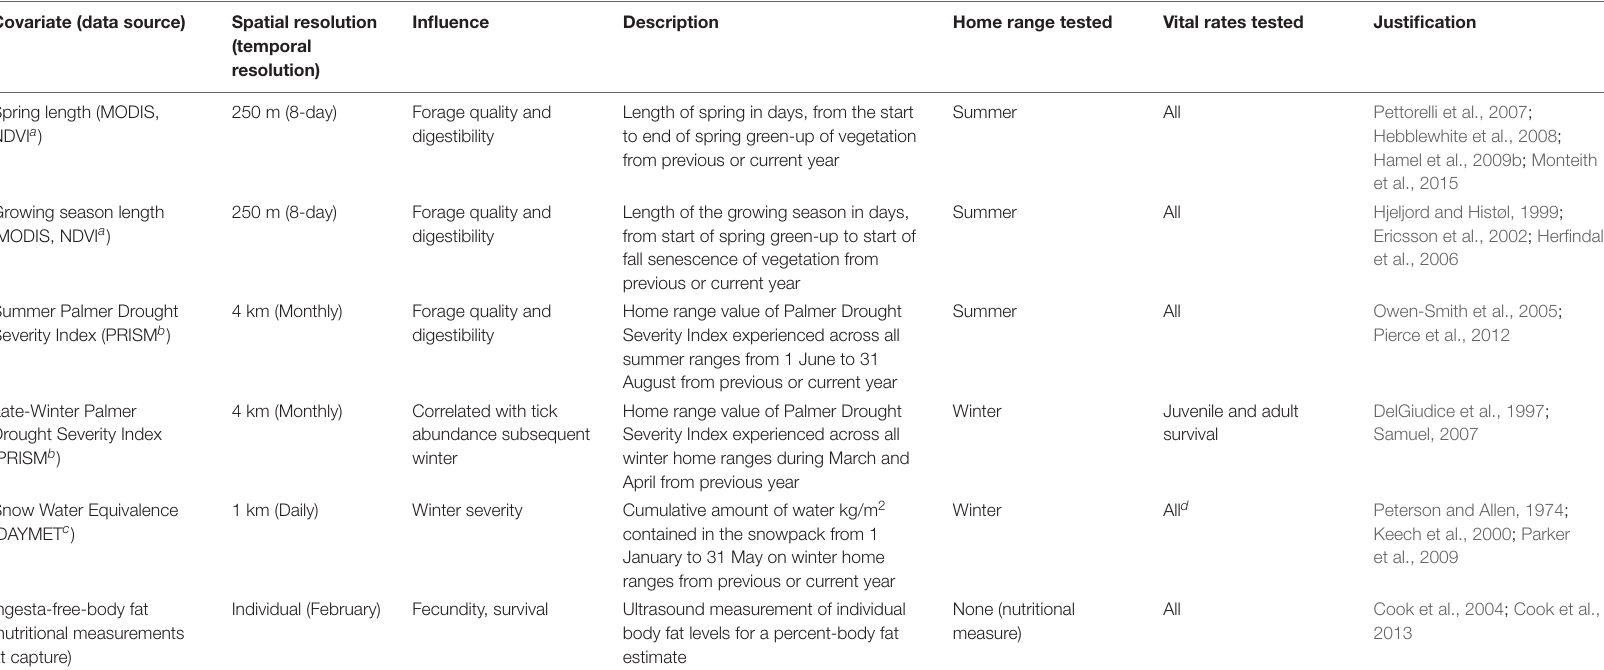
TABLE 1 | Descriptions of covariates evaluated for their relative influence on probability of pregnancy, parturition, survival of juveniles (July–February), and overwinter adults (January–May) of Sublette moose from 2012 to 2014 moose in western Wyoming, United States. Covariate (data